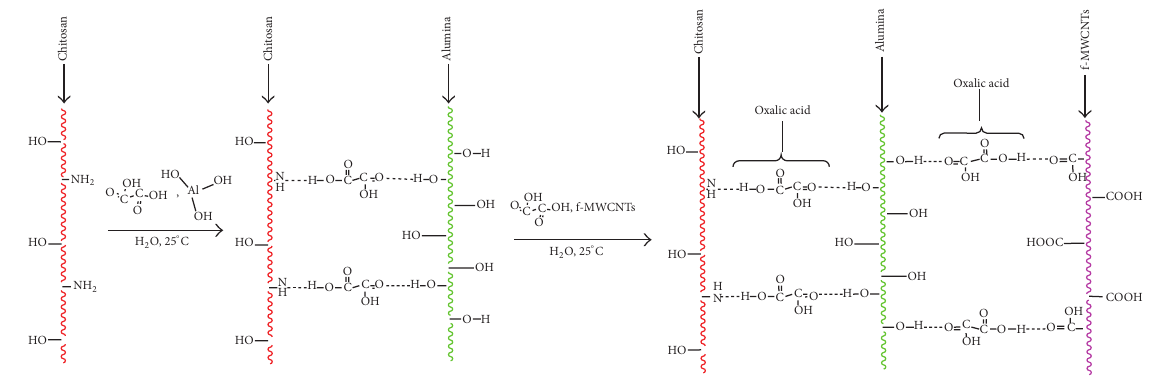
Figure 2: A schematic representation of the formation of chitosan-alumina/f-MWCNT nanocomposites. Table 1: Summary of bacterial strains used for the testing of the nanocomposites. Organism